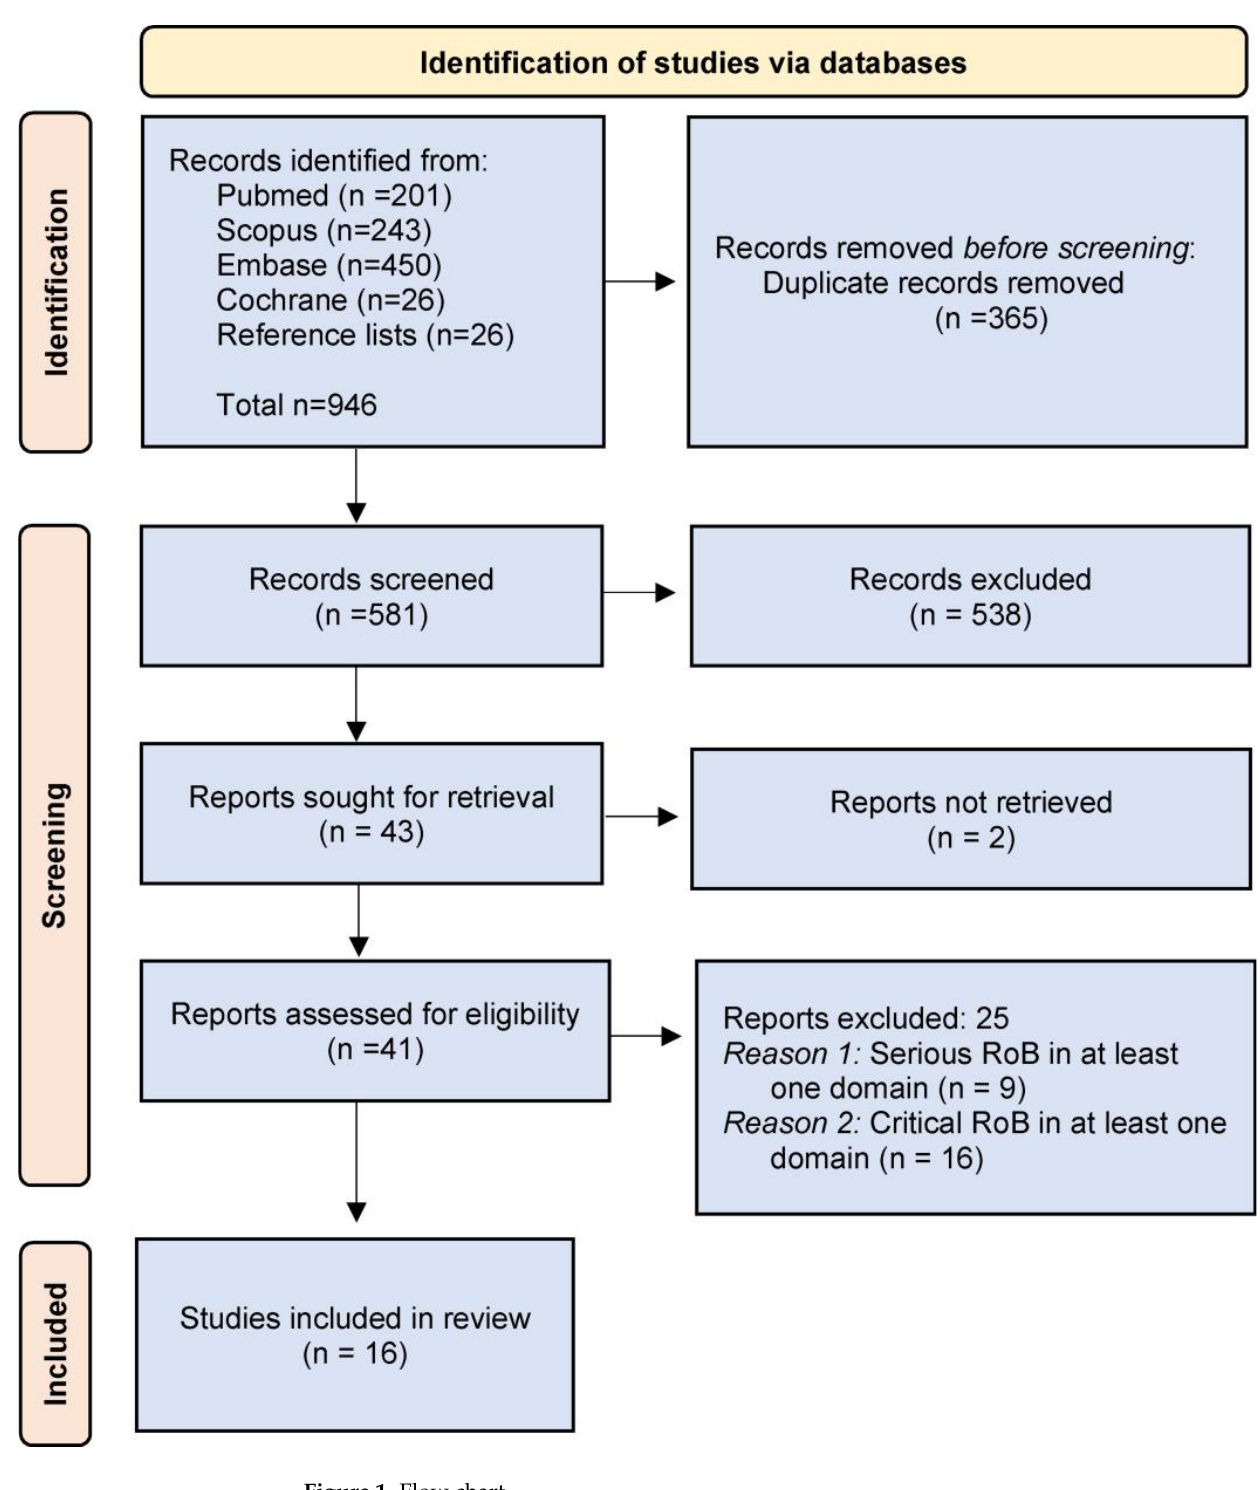
Figure 1. Flow chart.